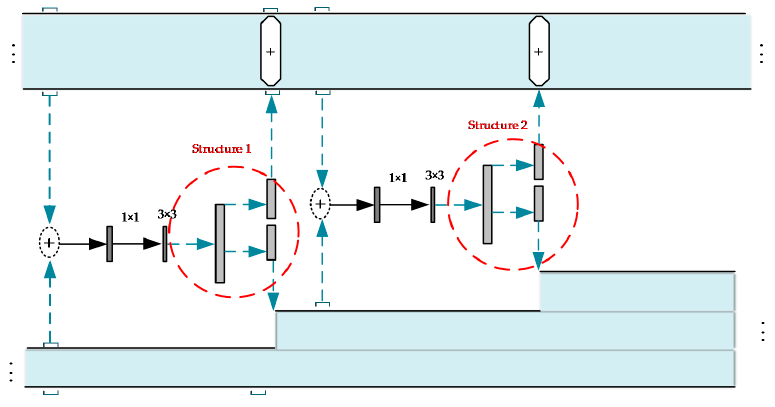
Figure 7. Dual Path architecture.